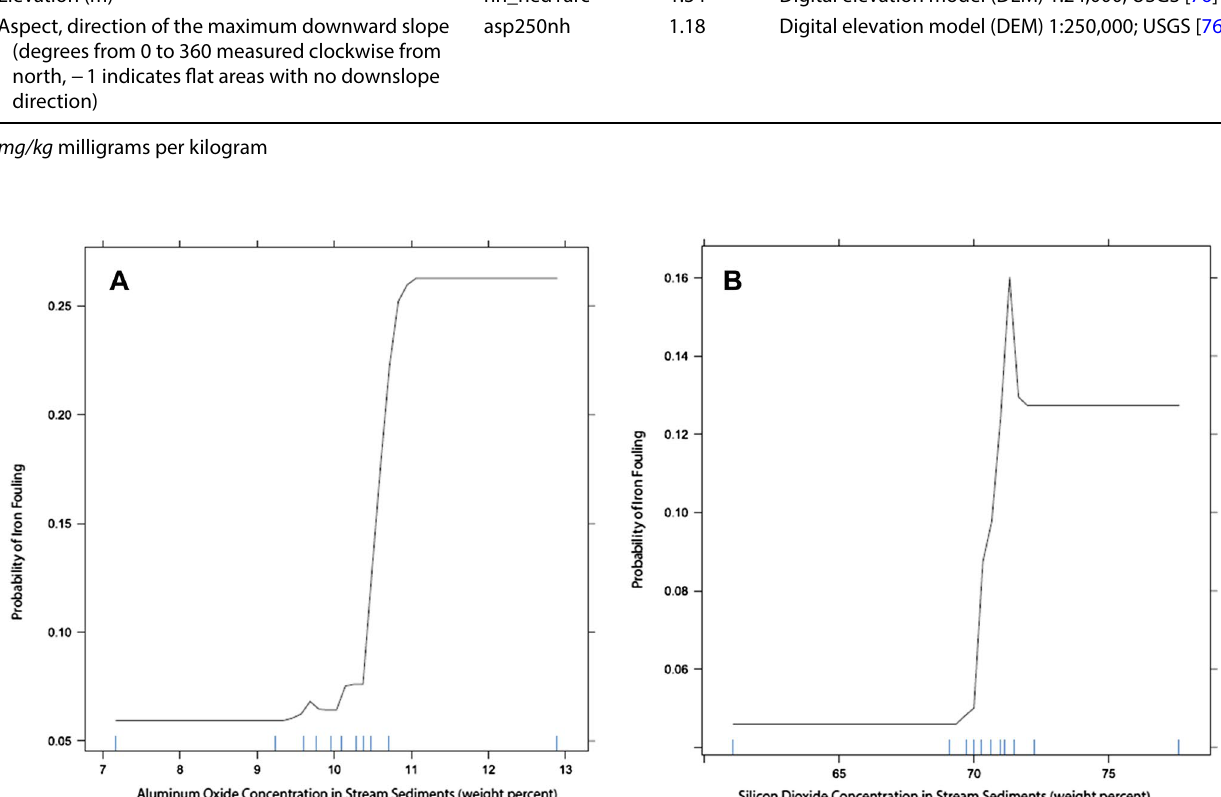
Fig. 3 Partial dependence plots for a aluminum oxide; and b silicon dioxide. The interior tick marks along the x-axis indicate the deciles of the variable in the model training dataset. Additional partial